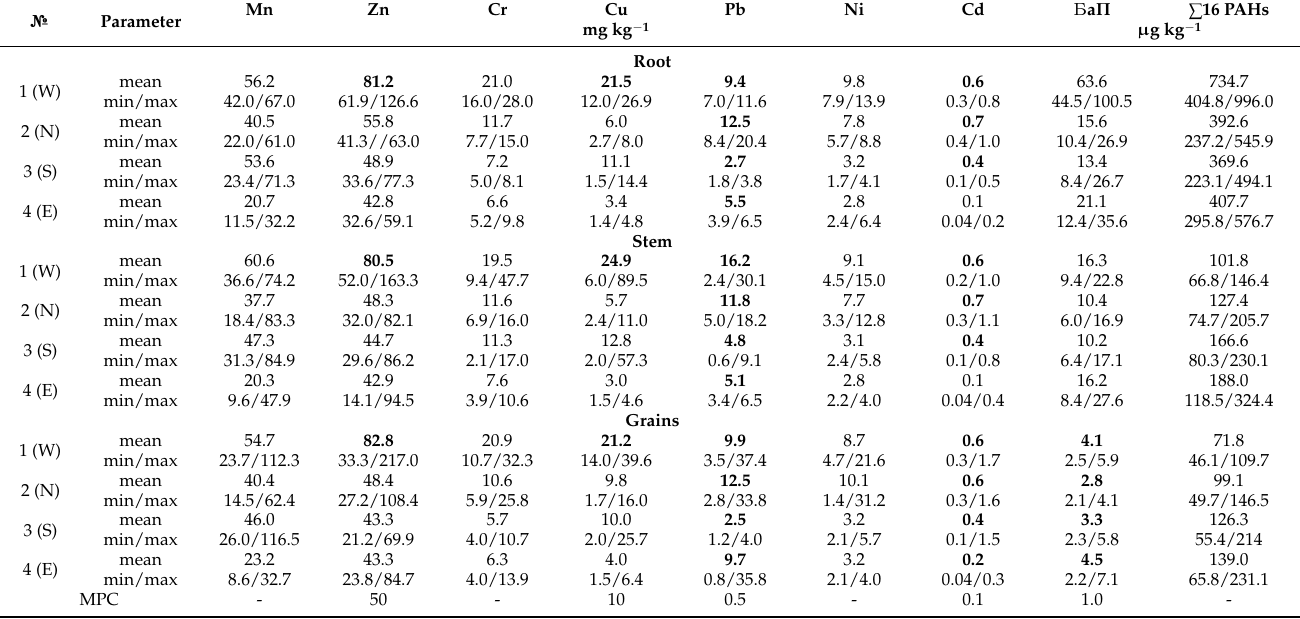
Table 3. Concentration of HMs, BaP, and 16 priority PAHs total amount ( ∑ 16 PAHs) in various parts of different parts of wheat sampled from agricultural fields located near the power station (2012–2021).